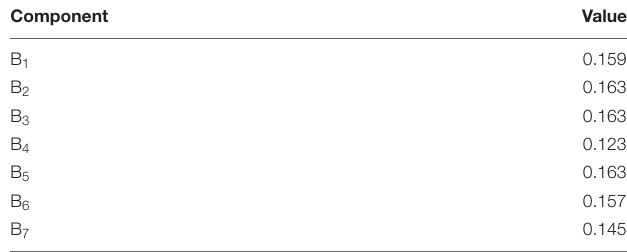
TABLE 6 | Component score coefficient matrix.